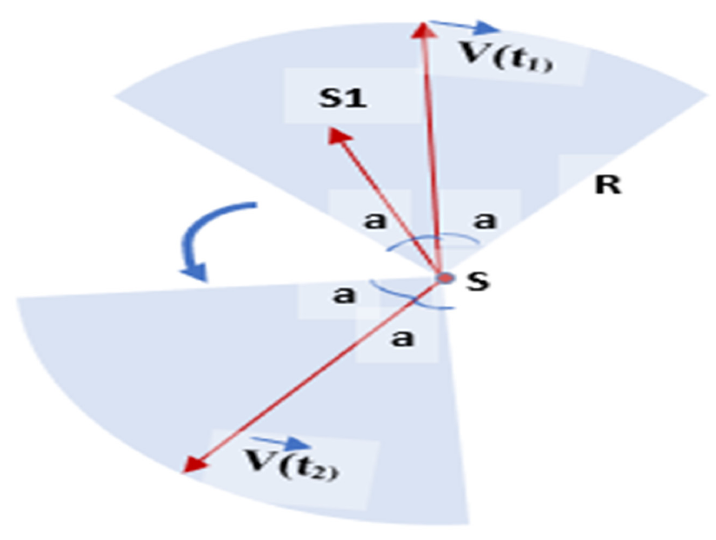
Figure 20. The Multi-layered Convex Hull set.